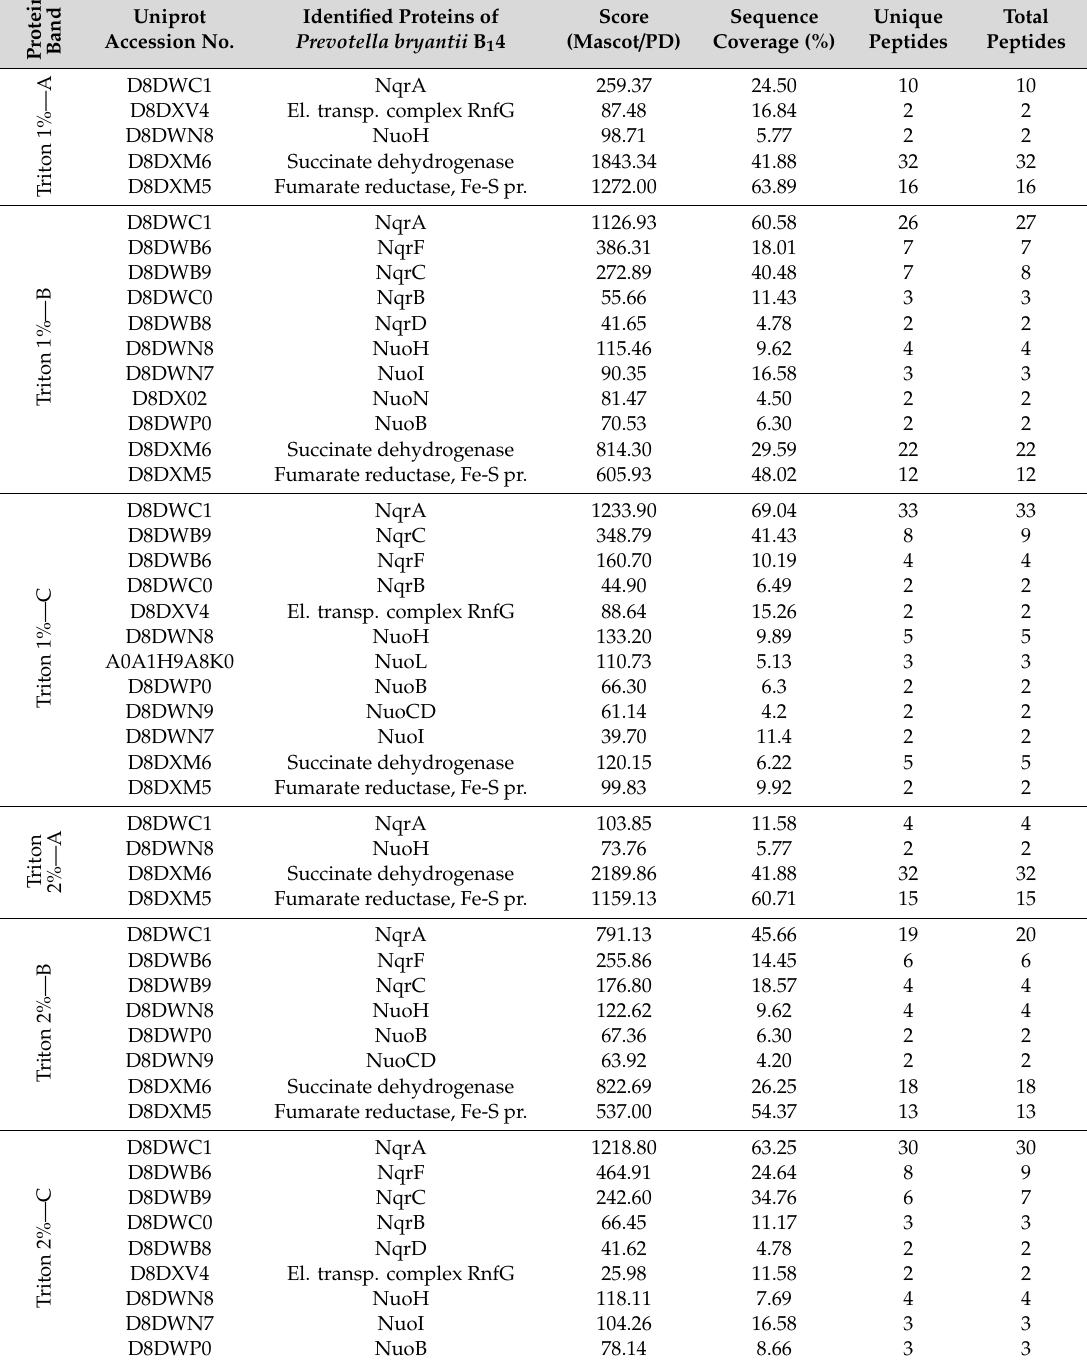
Table 4. Subunits of the NQR, RNF, NDH-I (Nuo), and other respiratory enzymes identified from membranes solubilized with 1% or 2% ( w / v ) Triton X-100. Bands were excised from the BN-PAGE as indicated in Figure S1. The entirety of identified proteins is listed in Table